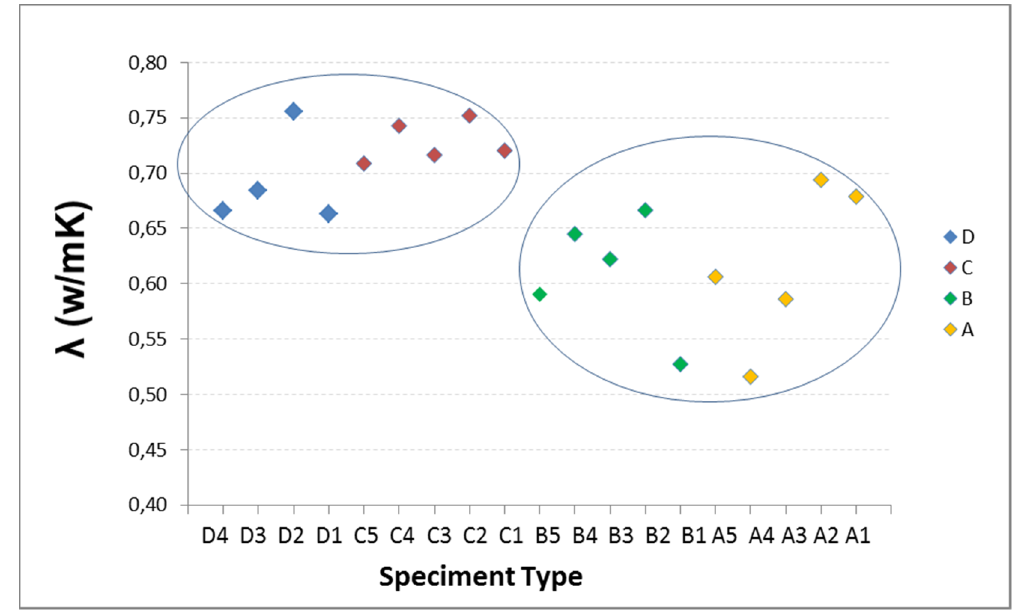
Figure 10. Influence of recycled aggregate percentage on thermal conductivity at 30